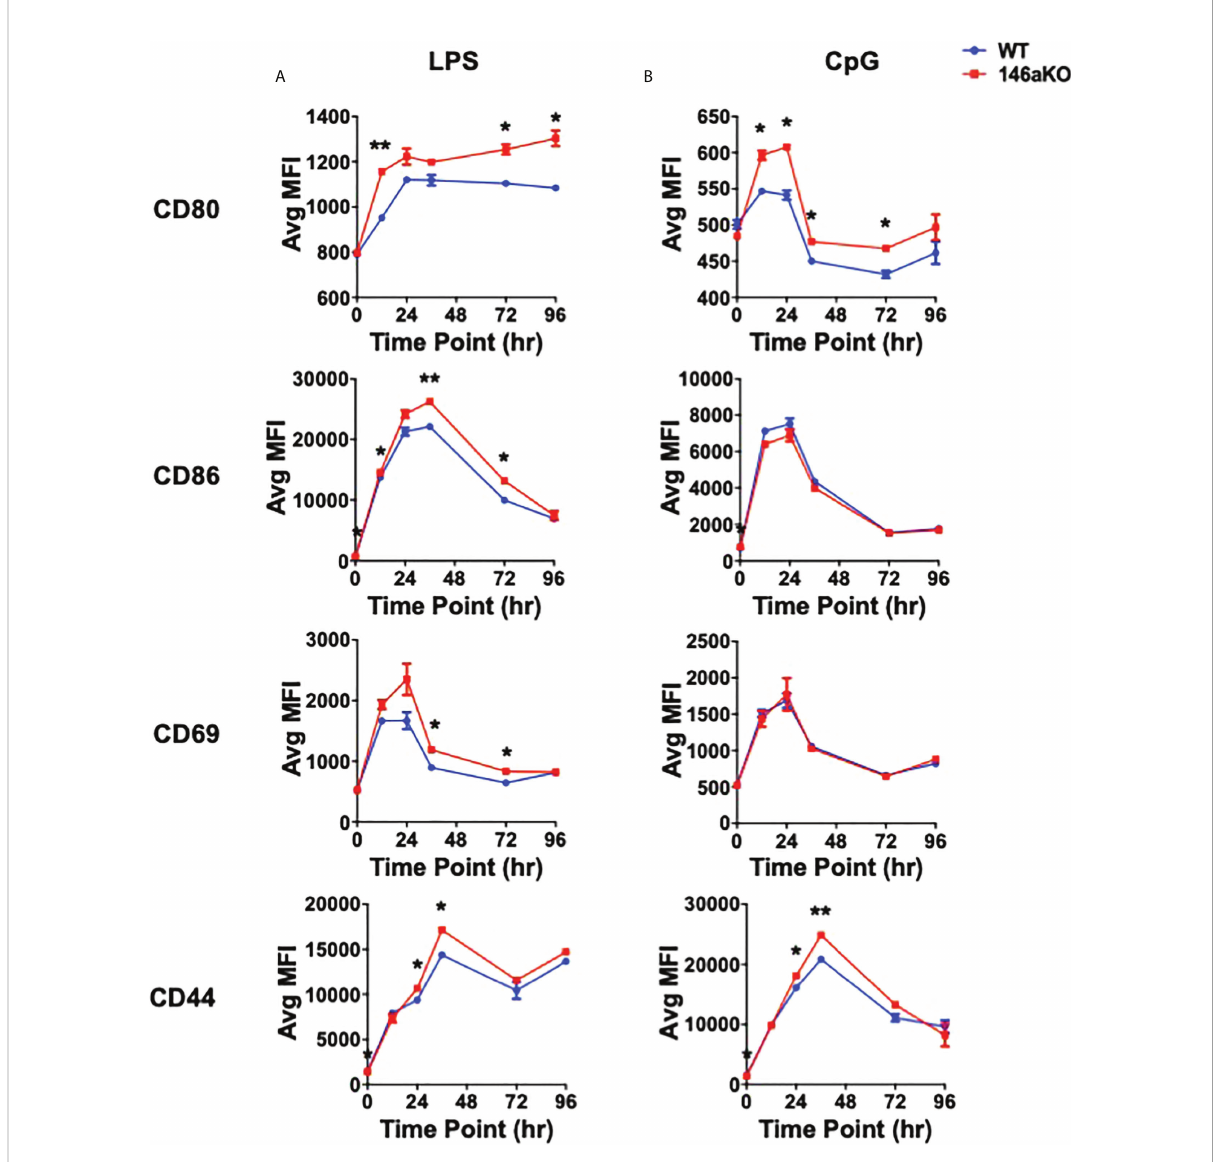
FIGURE 3 miR-146aKO B-cells have higher in vitro activation to T-independent antigens than WT. (A, B) FACS analysis of B-cell surface activation and/or co-stimulation markers are higher in miR-146aKO vs . WT when stimulated with (A) LPS and (B) CpG ( t test for respective time point comparisons; * P < 0.05, ** P < 0.01). Representative of three mice/group in duplicates, repeated in two independent